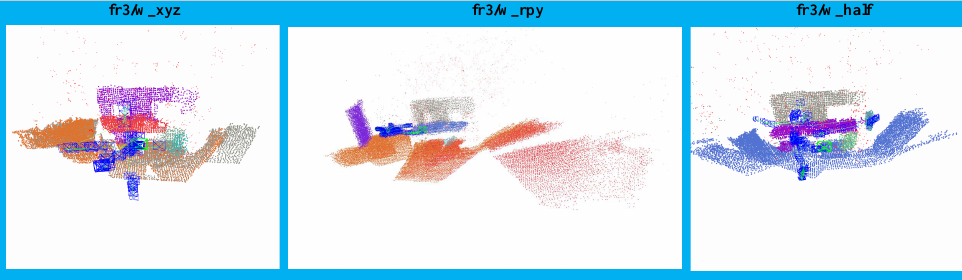
Figure 8. Global